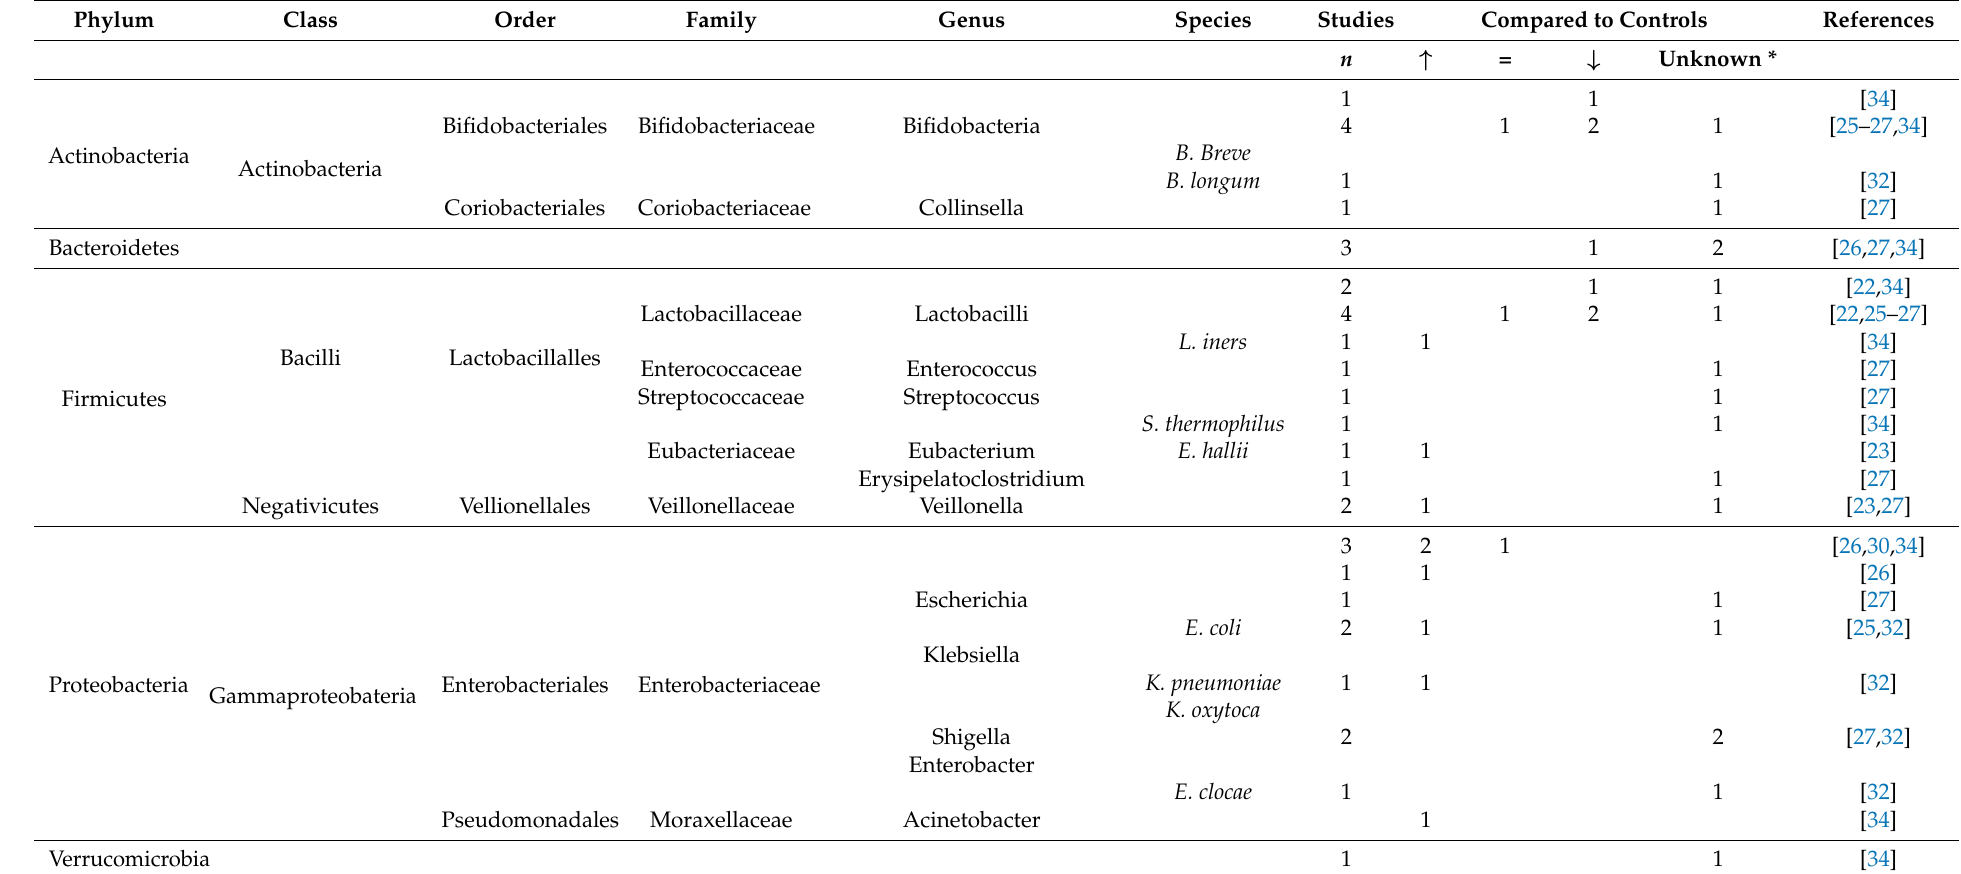
Table 2. Faecal microbiota of infants with colic compared to healthy controls. Results from research using 16S sequencing and/or